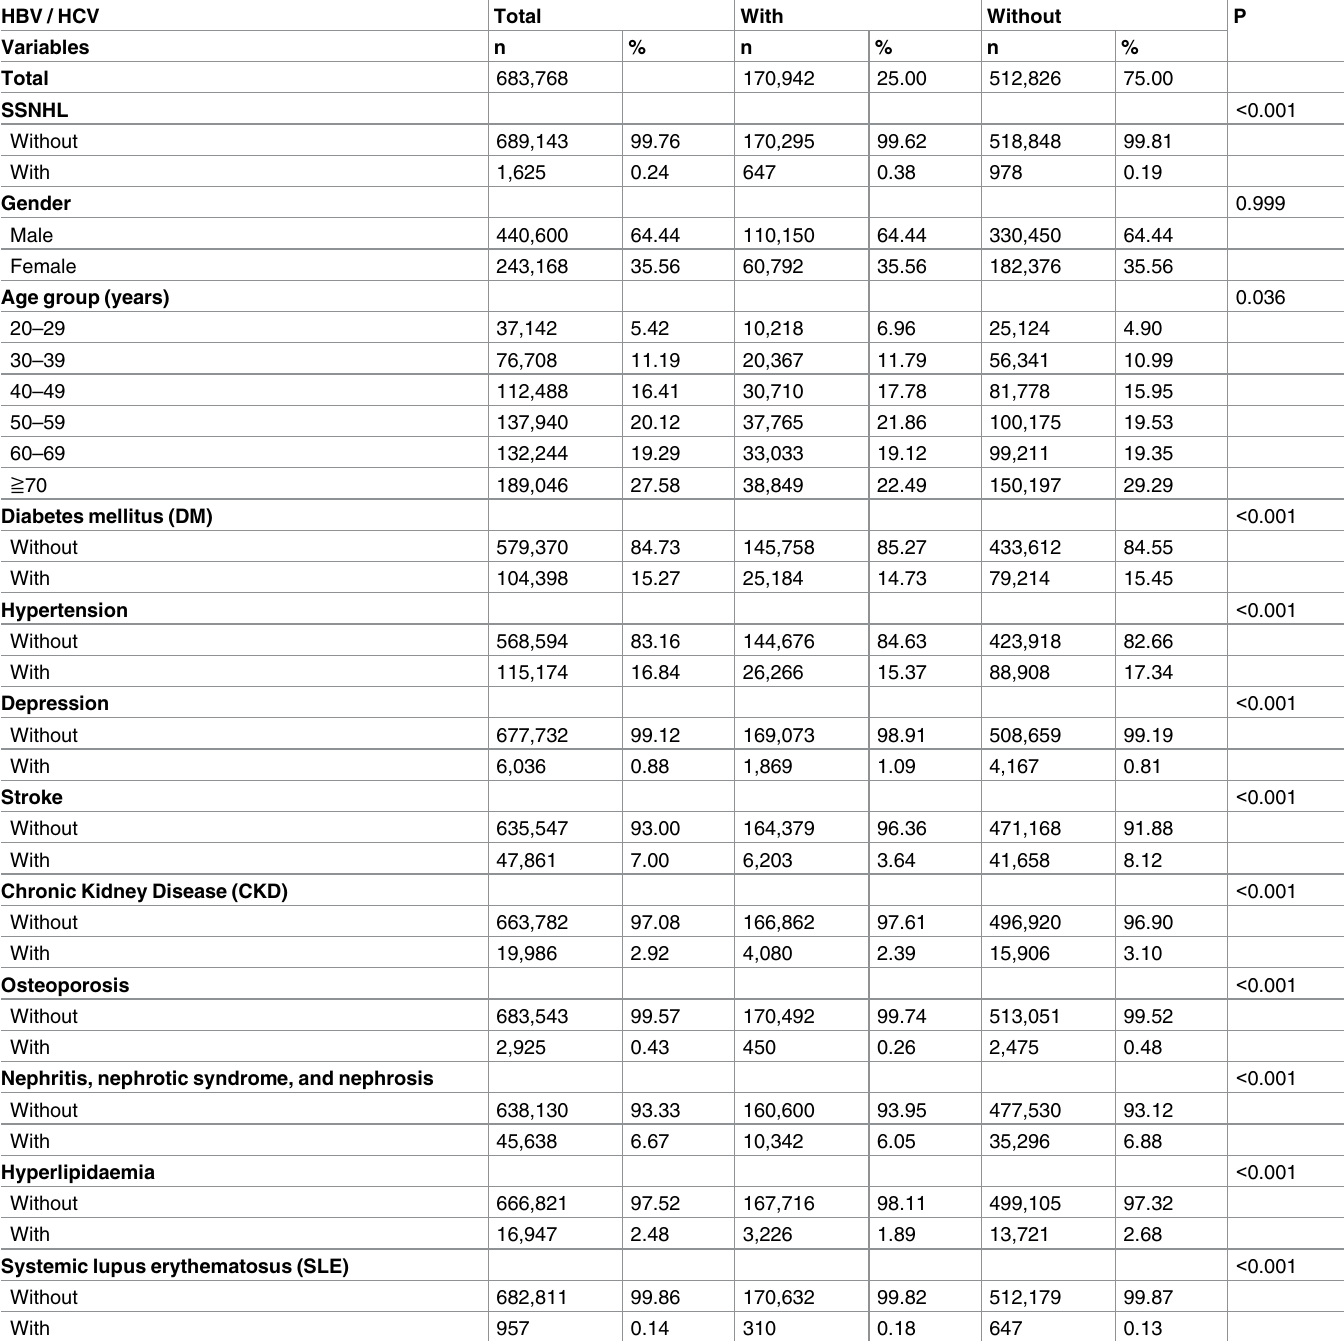
Table 1. Characteristics of the study participants at the end of